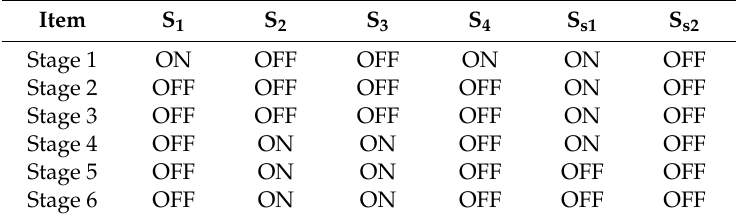
Table 3. Switching scheme in the first half switching period (secondary side modulation